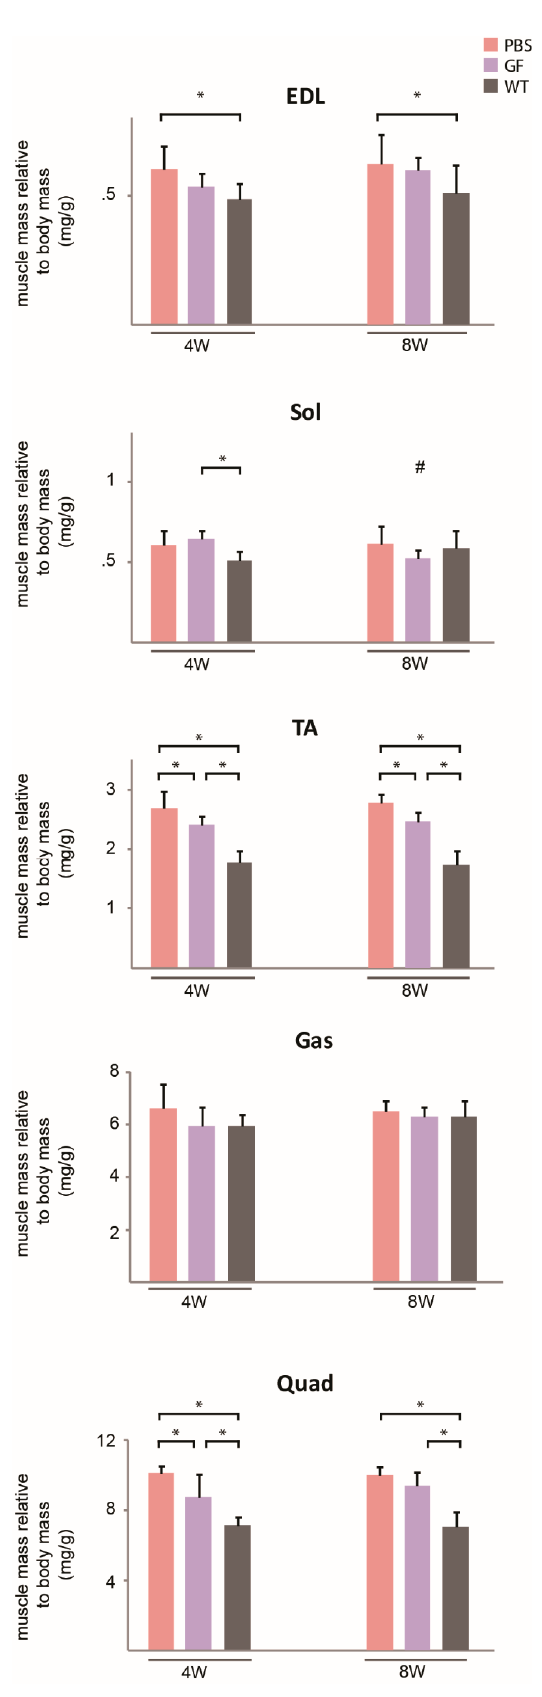
Figure 3. Muscle mass related to body weight. Muscle mass of EDL, soleus, TA, gastrocnemius, and quadriceps related to body mass at the conclusion of 12-week treatment period. 4W + 8W PBS; 8W